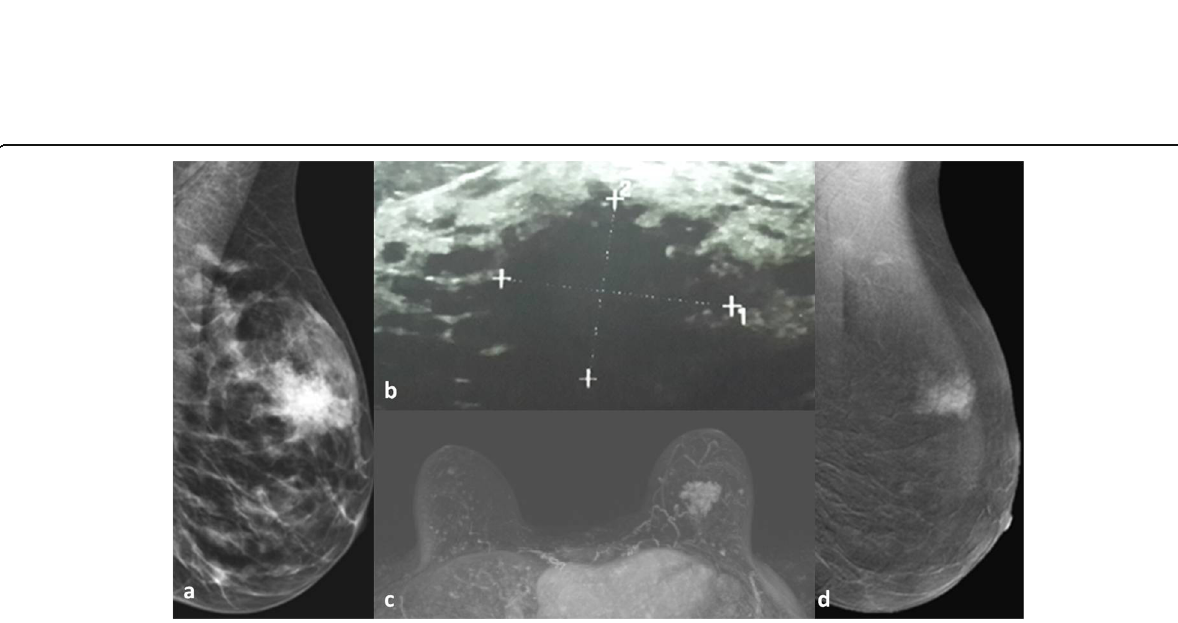
Fig. 4 Thirty-year-old patient with a left breast lump. SM revealed left breast UOQ speculated mass lesions ( a , b ). MRI showed an irregular not circumscribed speculated intense heterogeneously enhancing mass lesion ( c ). CEM showed an irregular not circumscribed speculated intensely heterogeneously enhancing mass lesion in left UOQ ( d ). The final diagnosis was sclerosing